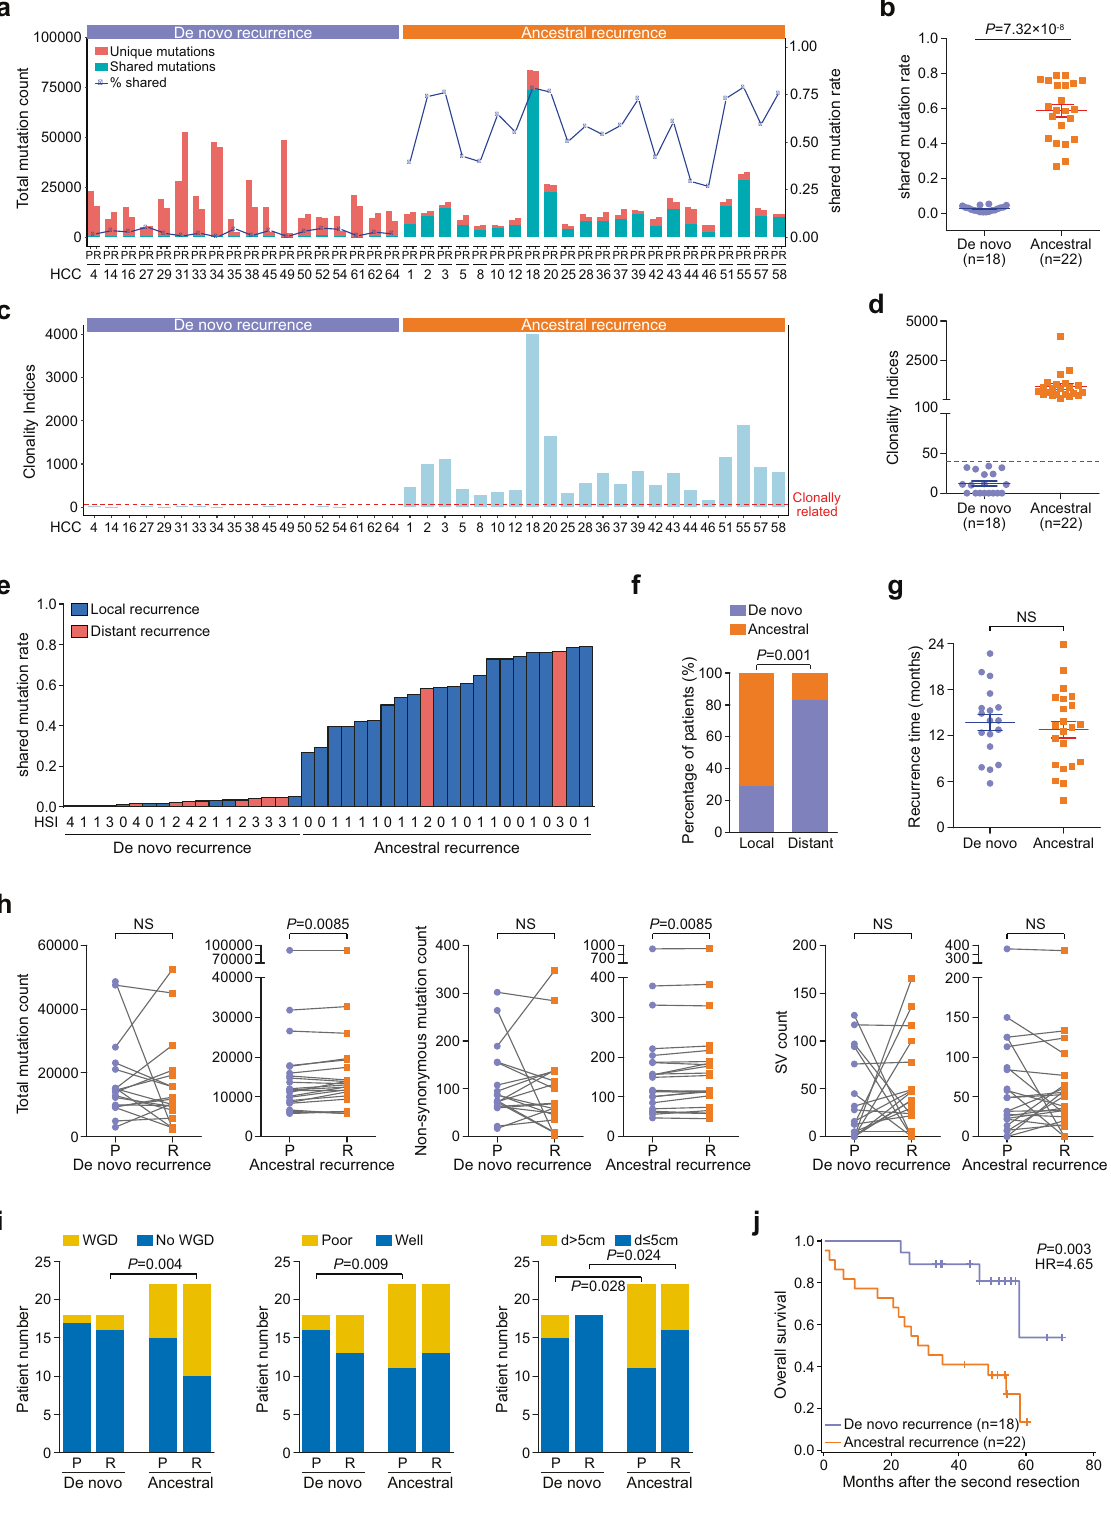
nonsynonymous mutations that were shared between the primary and recurrent tumors were clearly different between the patients with de novo recurrence and those with ancestral recurrence (mean: 0.8% vs. 66.4%, P = 6.51 × 10 − 8 , Mann − Whitney U test; Supplementary Fig. 2c, d). In the SV analysis, there were no shared